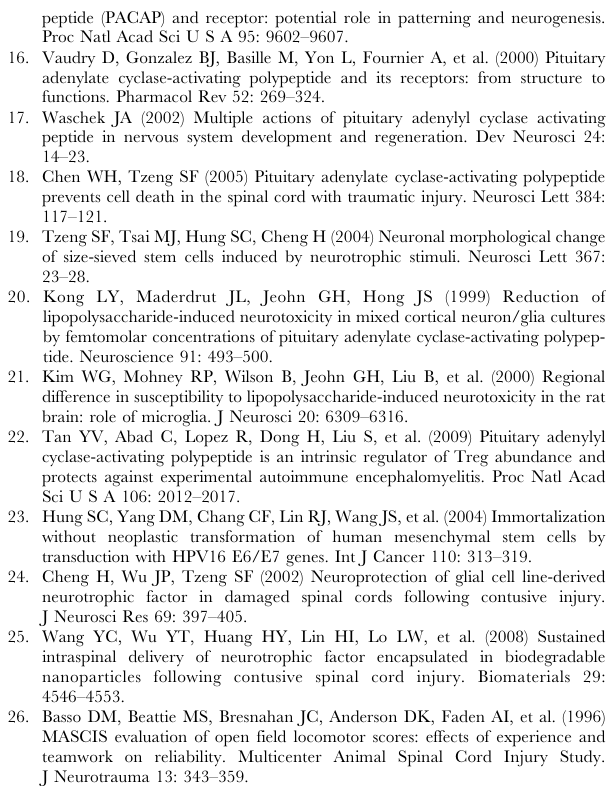
Table S1 A list of antioxidation- and signal transduc- tion-related protein spots identified by in-gel digestion